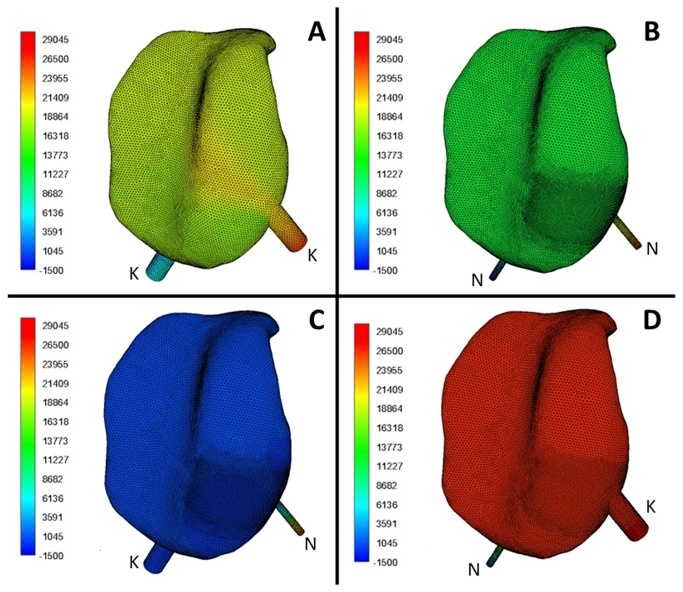
Pressure distribution in the upper compartment of a TMJ during a lavage process.The lavage process was conducted with (A) KK, (B) NN, (C) NK and (D) KN type needles. “N” and “K” represent the needle of smaller and bigger diameter, respectively. In acronyms, the former letter represents the inflow needle, and the later one indicates the outflow needle.